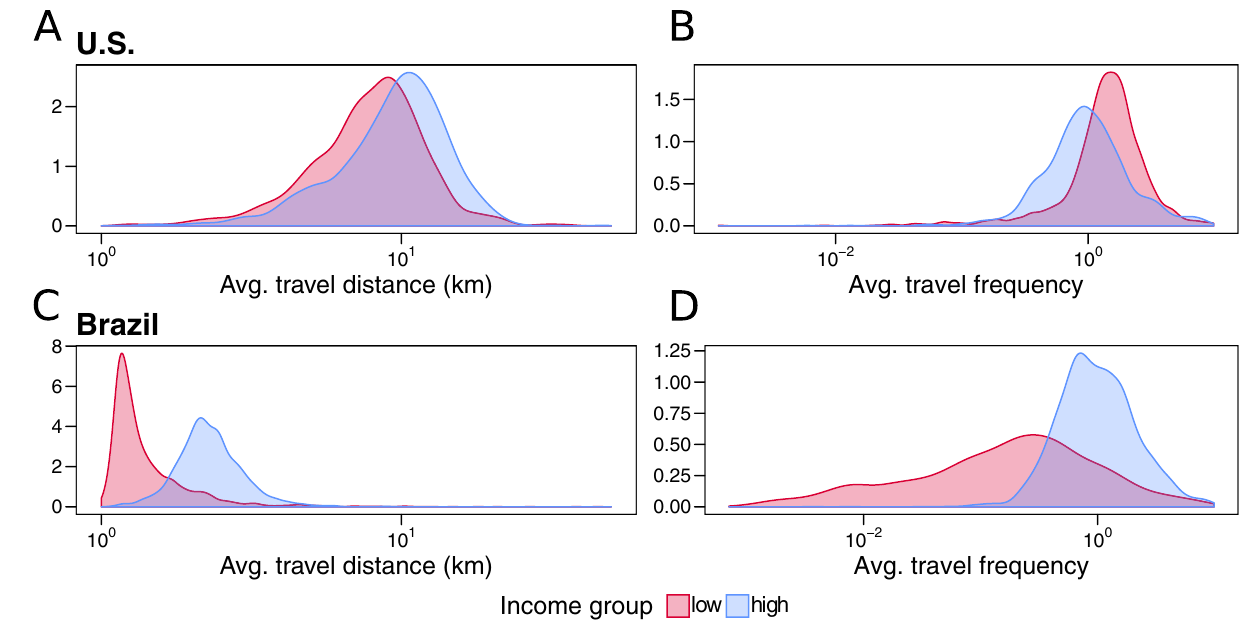
Figure 2. Distribution of mobility metrics. Equations (1) and (2) for the upper and lower 20% residents in terms of income. ( A ) In the United States, flows originating from low-income areas (red) tend to be of slightly shorter length compared to the ones from the high-income regions (blue). ( B ) The opposite trend exists for travel frequency suggesting that wealthier residents travel less as compared to their poorer counterparts. ( C ) Like in the United States, in Brazil, trips originating from low-income areas are significantly shorter in comparison with those from high-income zones. However, the discrepancy is more accentuated than in American cities. ( D ) Unlike the United States, the frequency of trips is also much higher for wealthier residents in